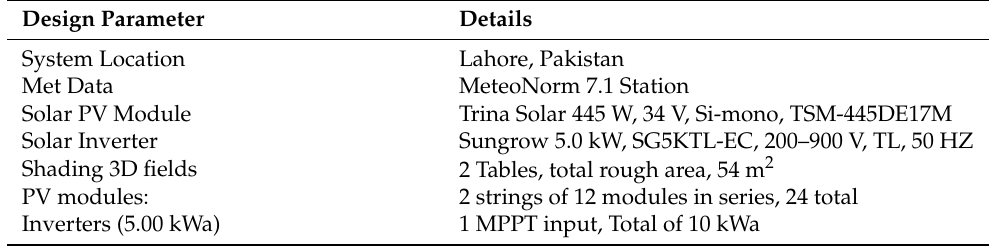
Table 1. System Design Parameters considered for performance ratio estimation.